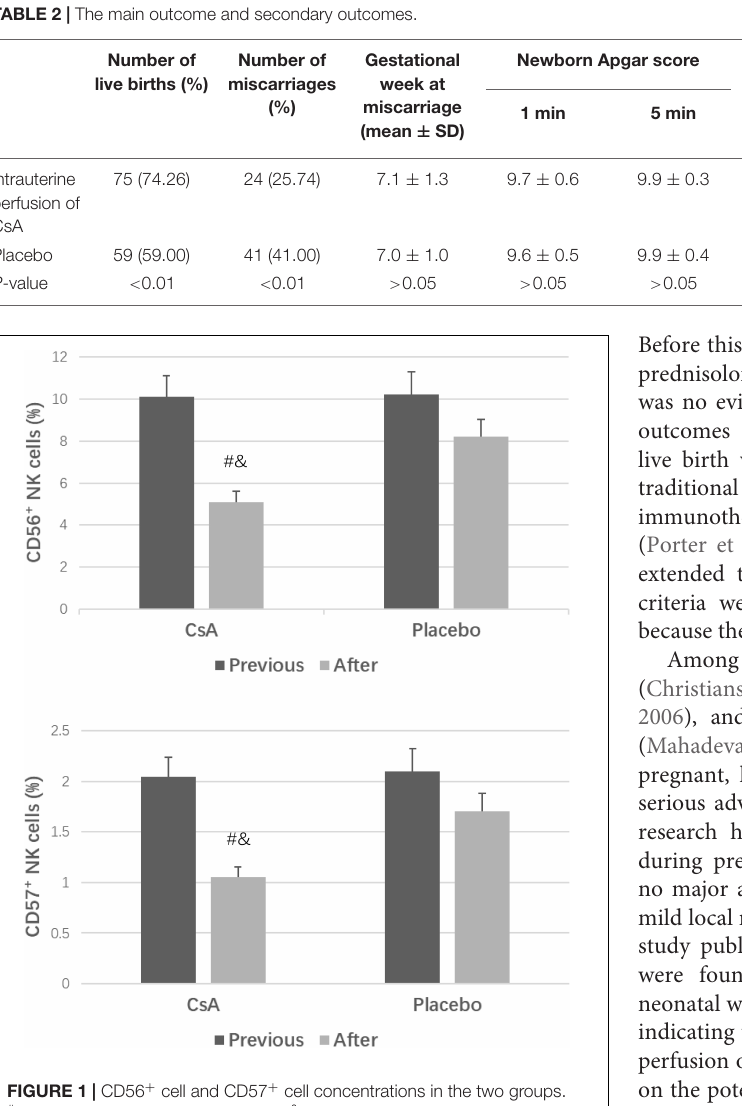
FIGURE 1 | CD56 + cell and CD57 + cell concentrations in the two groups. # P < 0.05 versus the placebo group, & P < 0.05 versus previous